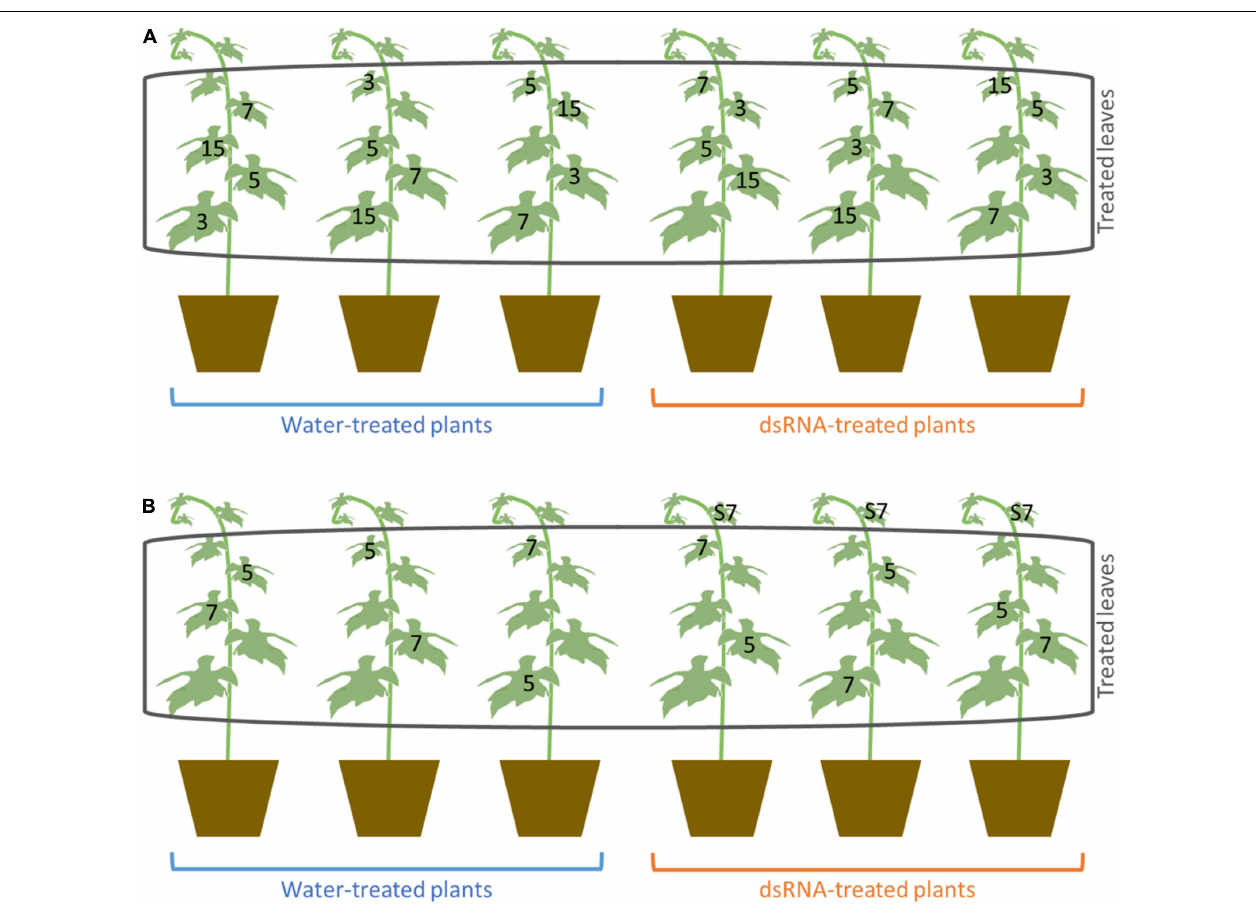
FIGURE 1 | Scheme of the treatment and sampling carried out in the first (A) and second experiment (B) . Numbers indicate the number of days after treatments (dat) at which the leaves were collected. S7 indicates the untreated leaves that were sampled at 7 dat for the evaluation of systemic activity of dsRNA in the second